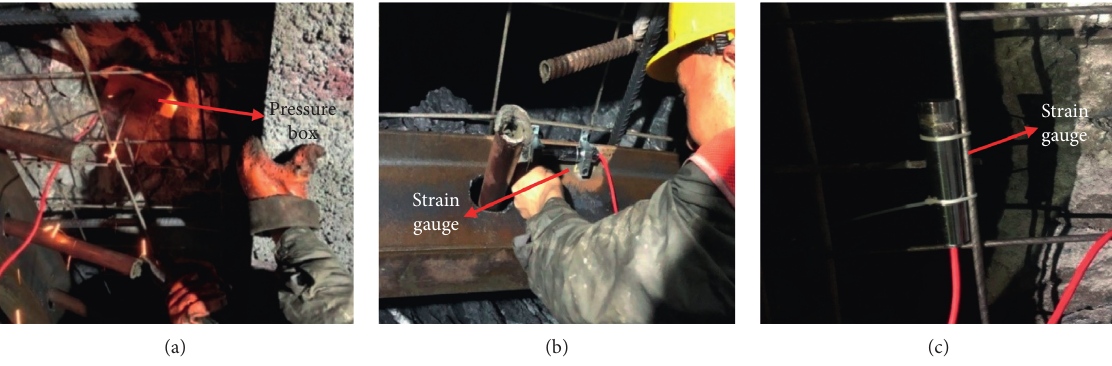
Figure 6: Field installation of the experimental devices: (a) pressure box; (b) steel arch strain gauge; (c) concrete strain gauge.